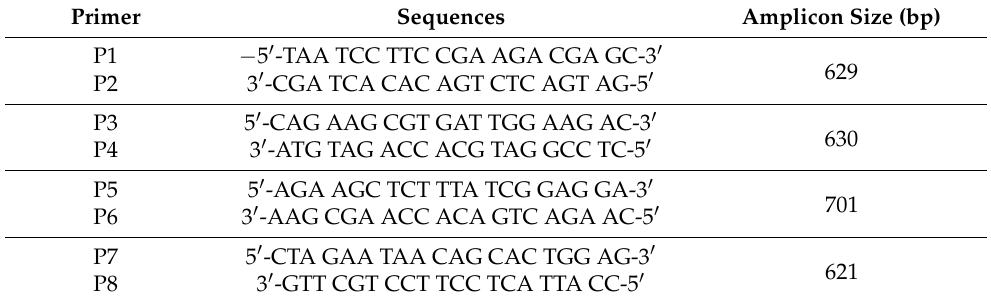
Table 2. Primers used in the